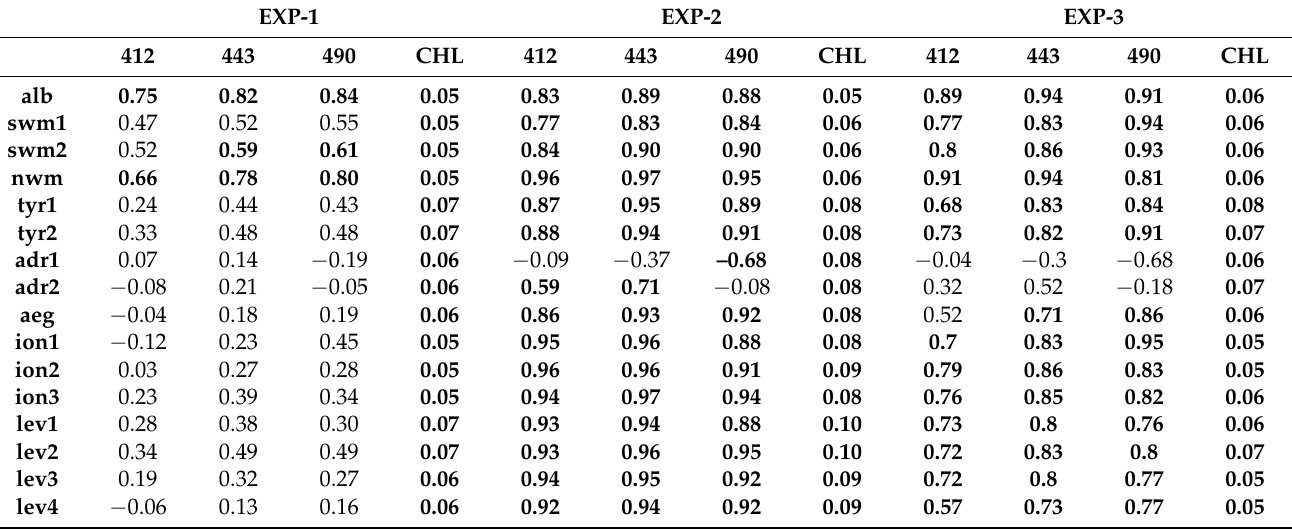
Table 1. Validation metrics of Rrs and chlorophyll for the three experiments. Data and model are spatially aggregated for the year 2017 over the sub-basins shown in Figure 4. Metrics are temporal correlation for Rrs(0+) at 412 nm, 443 nm, and 490 nm, with respect to CMEMS Rrs ocean color (OC) product [41], and RMSD (units mgChl/m 3 ) with respect to CMEMS satellite chlorophyll product [39]. Entries in bold indicate that correlation is significant with p -value <